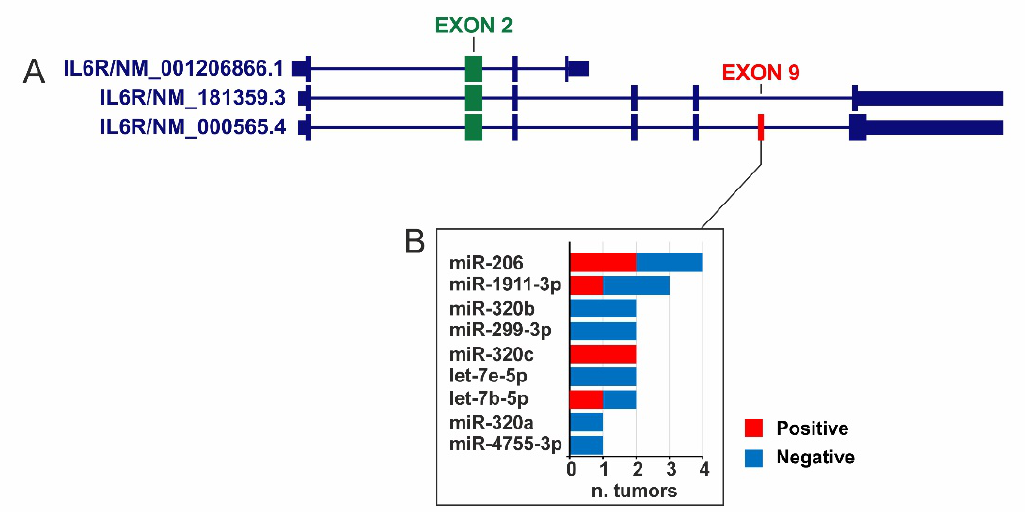
Figure 6. Correlation analysis of miRNAs targeting the sequence of Exon 9. ( A ) IL6R gene isoform according to RefSeq annotation (assembly: GRCh37/hg19). ( B ) In the left box miRNAs targeting Exon 9 with Pearson’s r ≤ −0.3 or ≥ 0.3 ( p ≤ 0.05) are described. For each miRNA the number of TCGA tumors in which this is significantly correlated is reported.